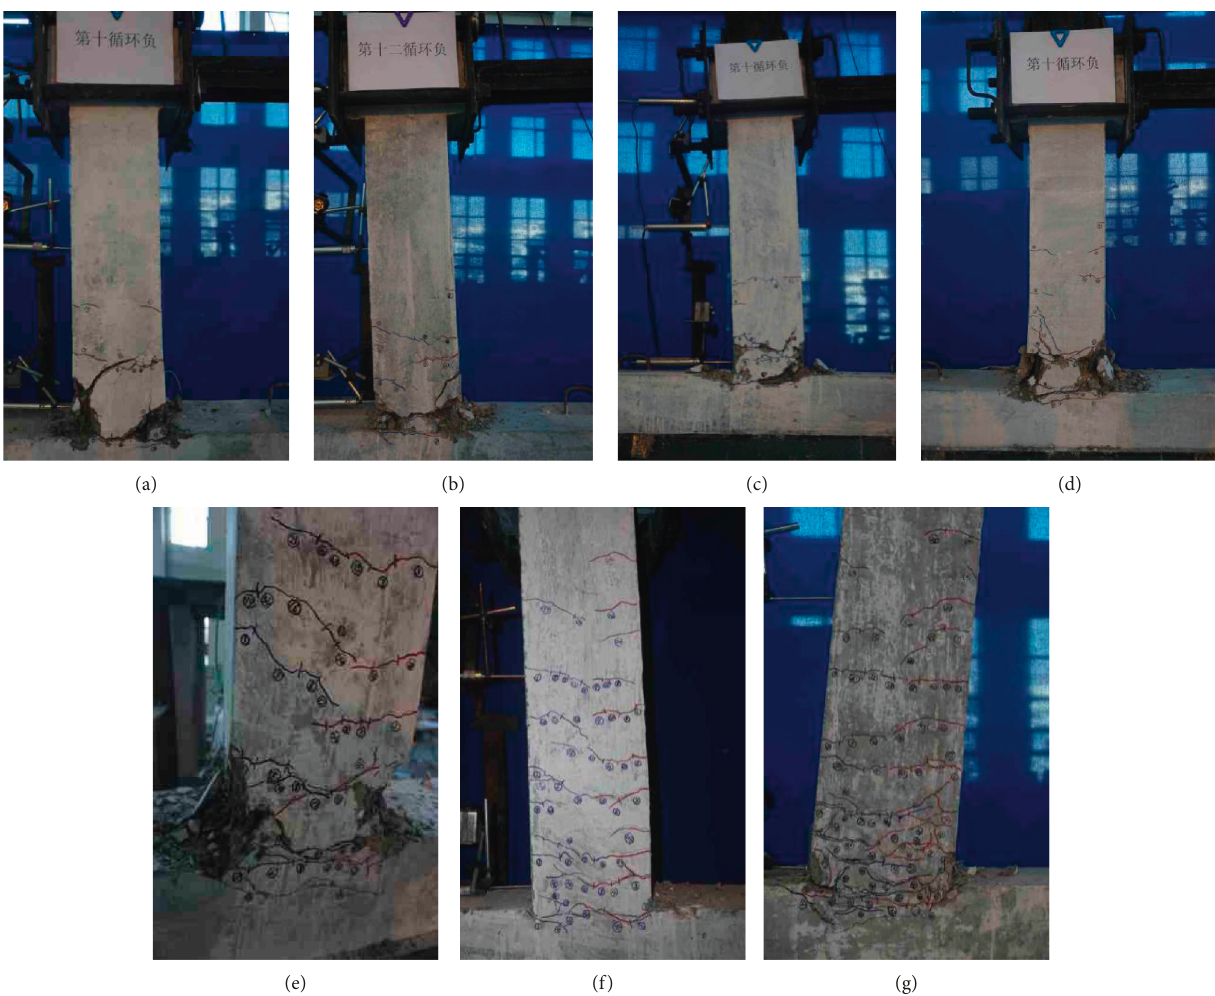
Figure 6: Failure details of the seven specimens. (a) PC1. (b) SC1. (c) SC2. (d) SC3. (e) TSC1. (f) TSC2. (g)